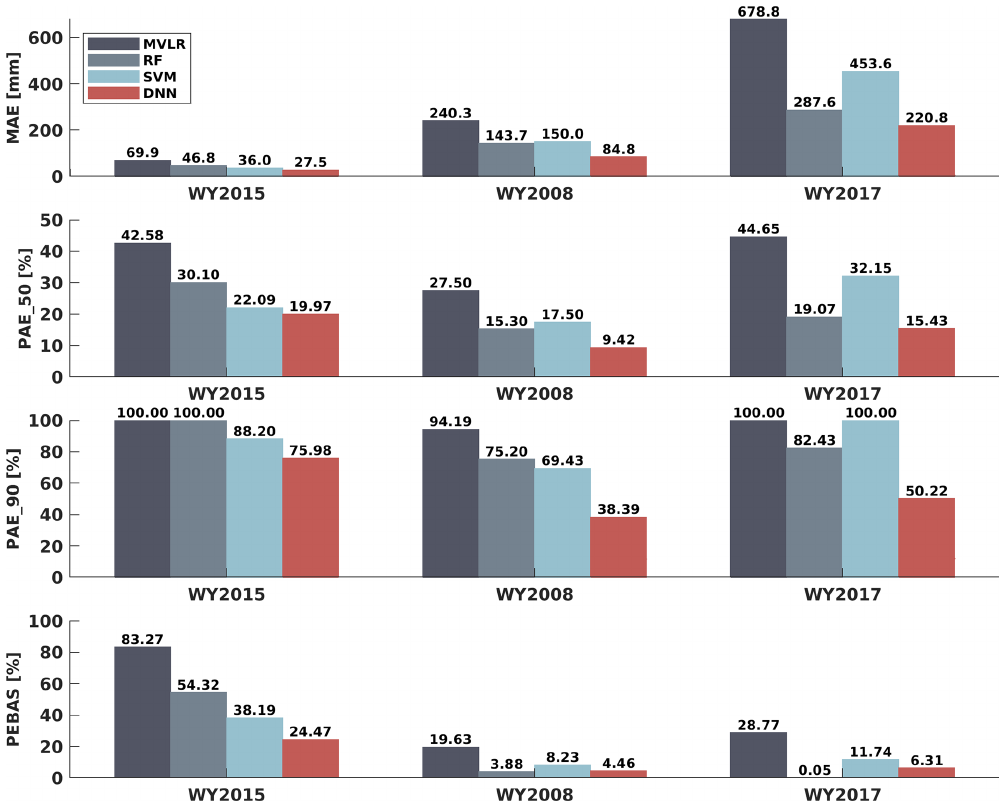
Figure 3. Mean absolute error (MAE), median of percent absolute error (PAE_50), 90th percentile percent absolute error (PAE_90) and percent error of basin-averaged SWE (PEBAS) of domain-wide SWE estimates based on MVLR, RF, SVM and DNN in WY2015 (dry year), WY2008 (normal year) and WY2017 (wet